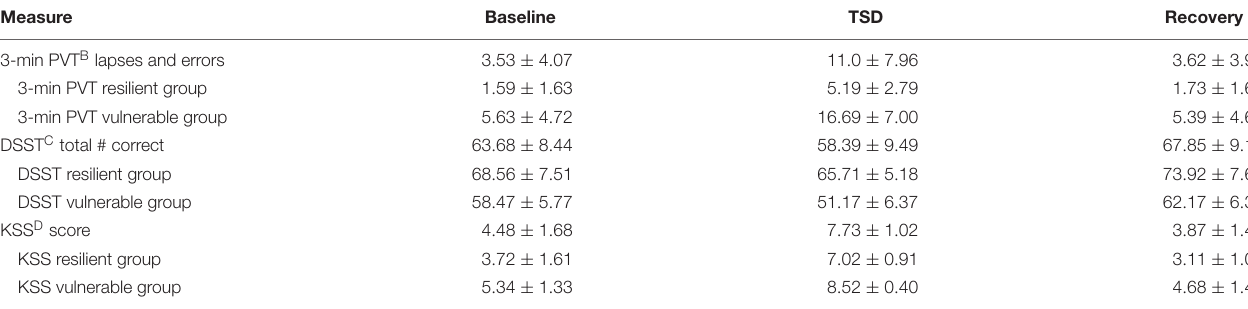
TABLE 2 | Neurobehavioral measures during baseline, total sleep deprivation (TSD), and recovery A during the 5-day experiment (mean ± SD). Measure Baseline